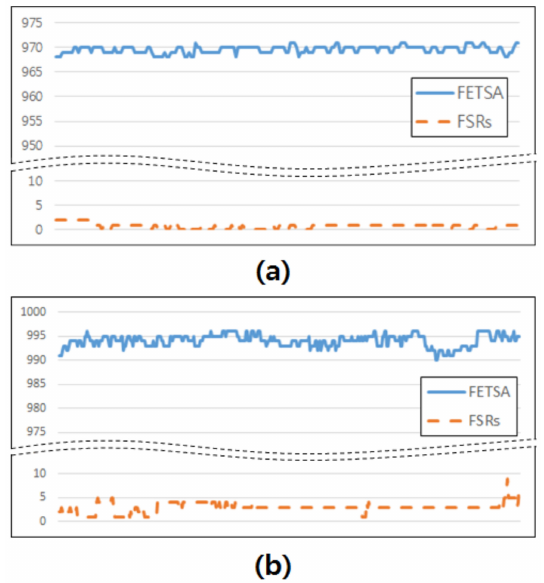
Figure 10. Comparison of the results using FETSA and FSRs: ( a ) the subject remained motionless, ( b ) the subjects made the “thumbs-up” motion.